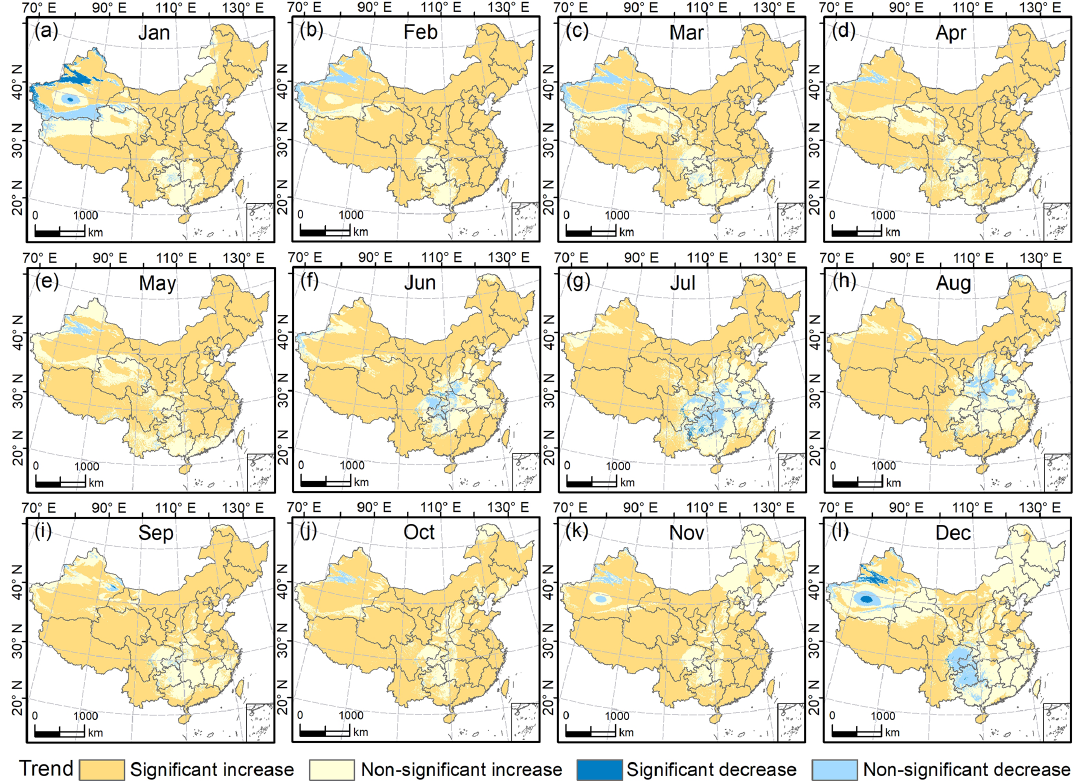
Figure 7. Monthly trends of Tmean changes in China during 1951–2020 obtained by the Theil–Sen median slope analysis. The significance of the trends is quantified by the Mann–Kendall statistical test at the 95% confidence level. The separate Theil–Sen trend analysis and MK test results for Tmean, Tmax, and Tmin are provided in the Supplement (Figs.